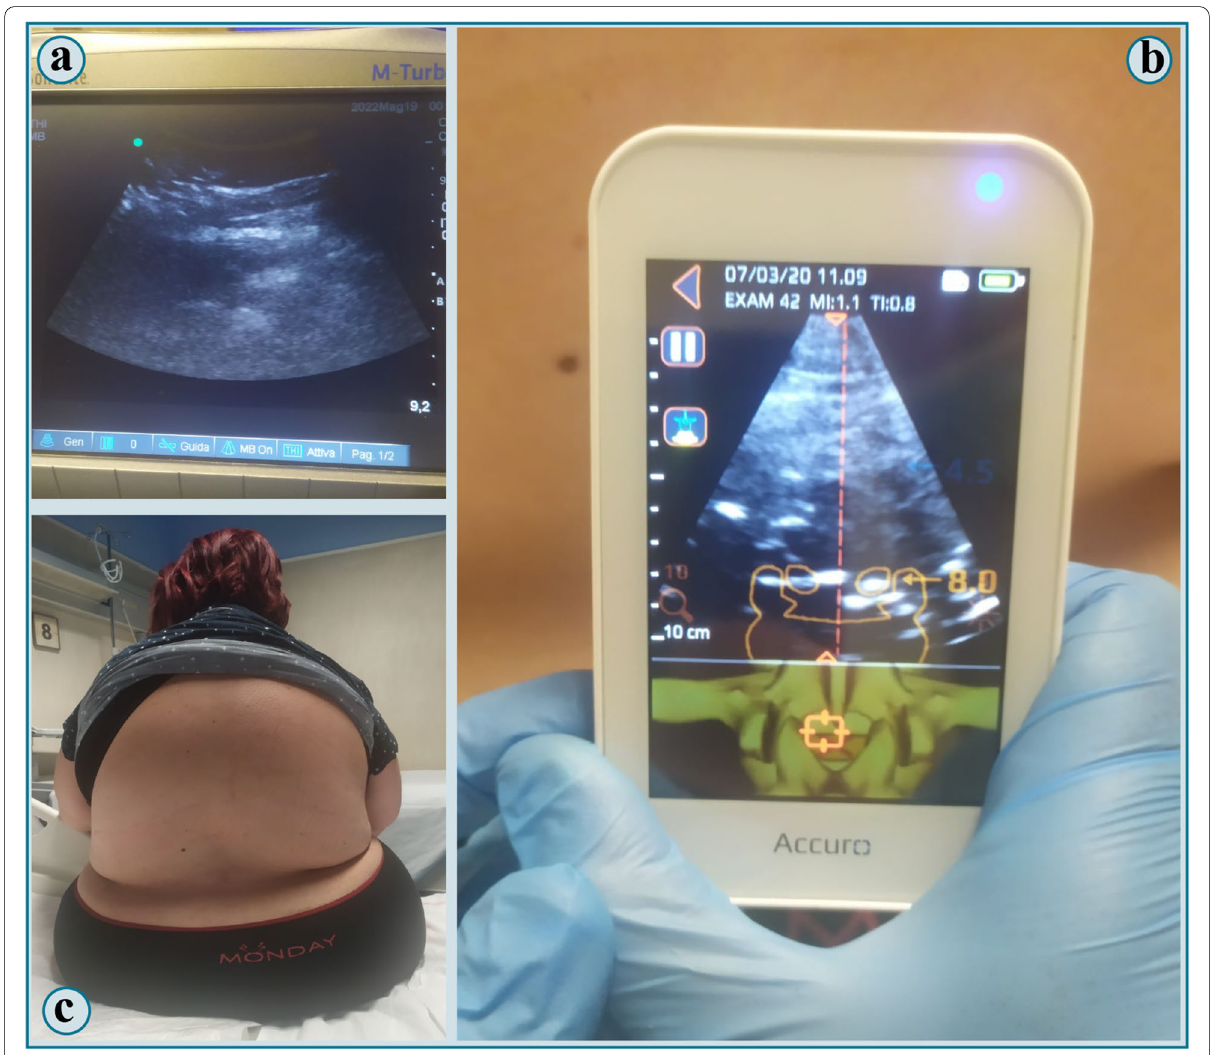
Fig. 1 a Image obtained with s-US; b image obtained with AI-US; c surface anatomy of the parturient’s back: no anatamical landmark can be identified with